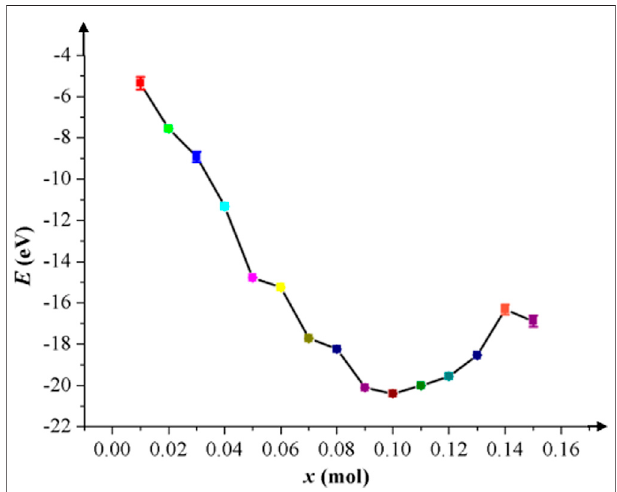
FIGURE 4 | Schematic diagram of the lithiation formation energy E with different x . The error bars showthat the accuracy of our calculations is credible.